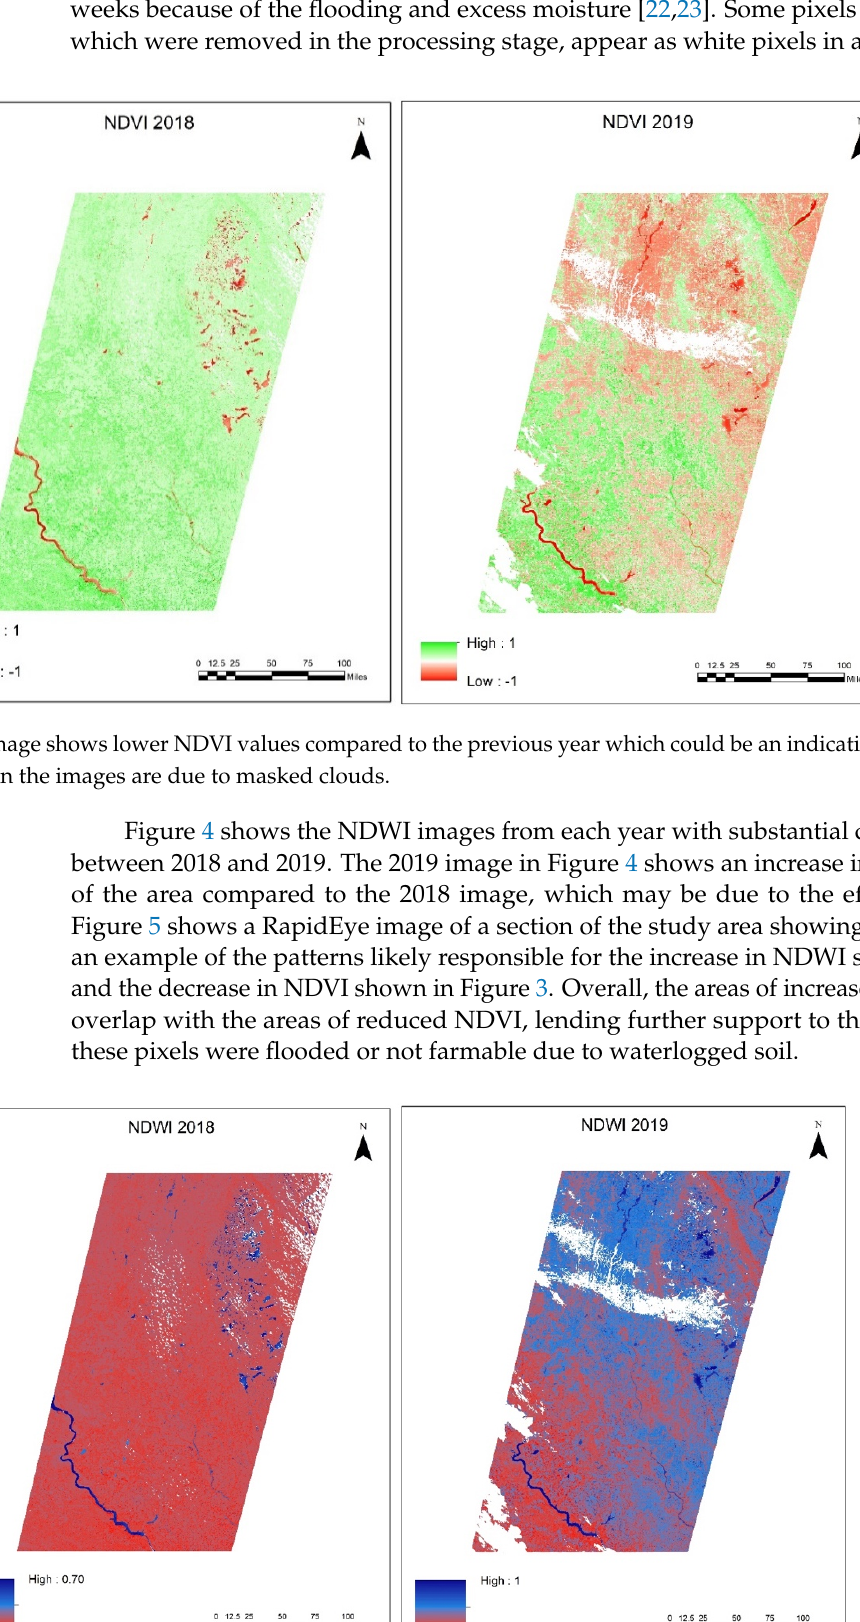
Figure 5. A June 2019 RapidEye image showing flooded fields in Letcher town of Sanborn County, South Dakota [24]. Figure 6 shows the NDVI and NDWI difference images. The red color in Figure 6 (left) indicates areas where the NDVI value from 2018 was greater than that of 2019 (in- terpreted as vegetation loss) while the green color indicates areas where 2019 NDVI values were greater compared to 2018 (vegetation gain). This vegetation loss is likely due to the direct effects of flooding indicating the presence of water, soggy soil, or indirect effects of flooding leading to late crop planting or fallow fields. Conversely, the NDWI difference map (Figure 6, right) shows areas where the NDWI values were higher in 2018 than in 2019 indicated in red whereas parts where NDWI values were higher in 2019 are indicated in blue. Higher NDWI values are expected in 2019 compared to 2018 in flooded areas, hence negative values can be interpreted as possible flooded areas on this map.